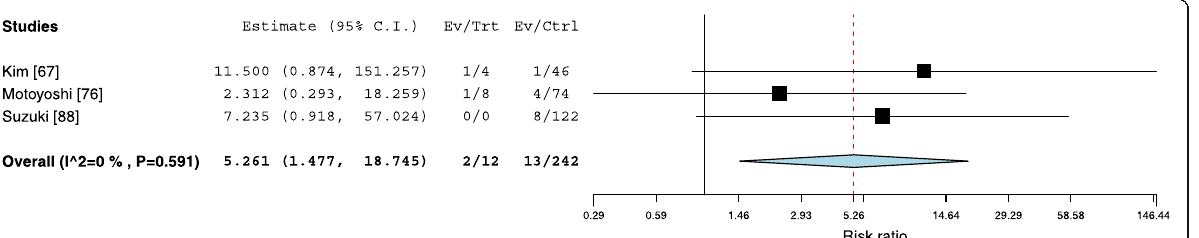
Fig. 9 Forest plot showing the risk ratio for failure when OMIs penetrated the maxillary sinus. Trt (OMIs perforating sinus), Ctrl (OMIs without sinus